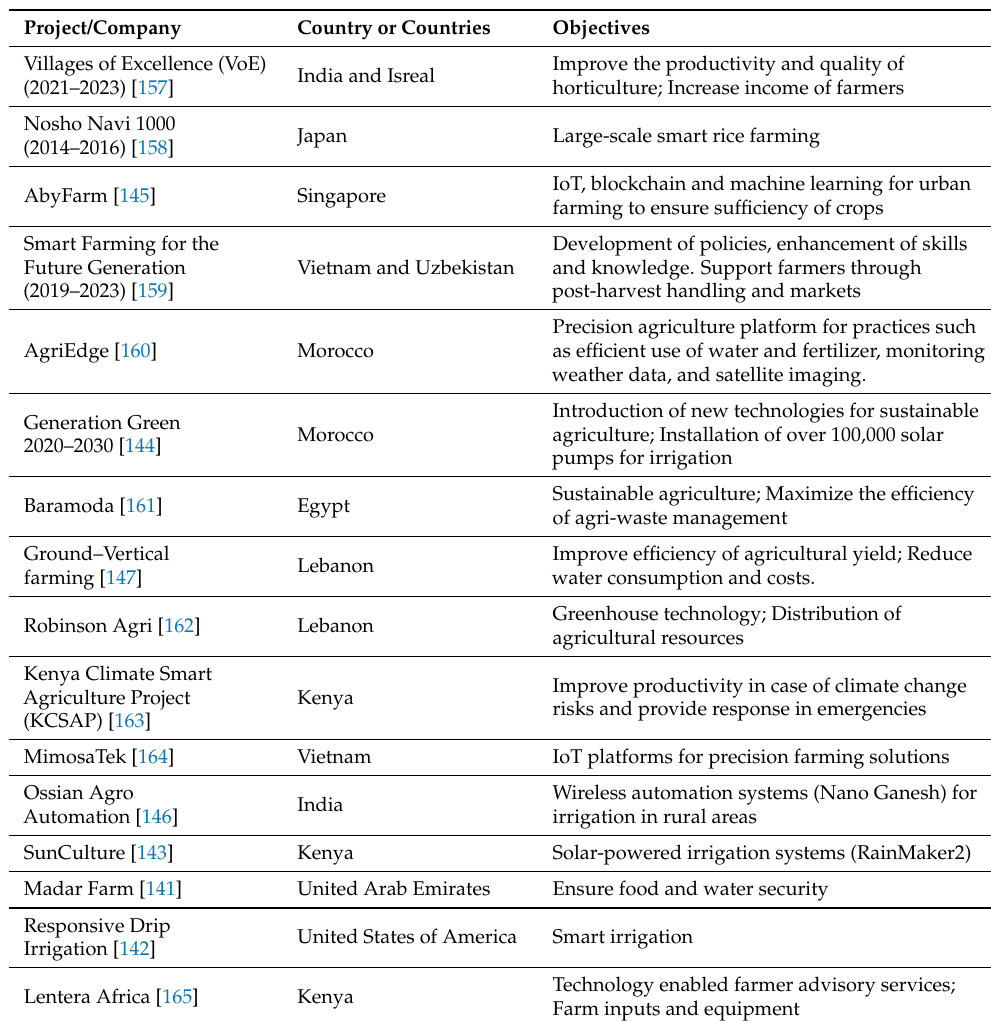
Table 6. Smart Farming initiatives